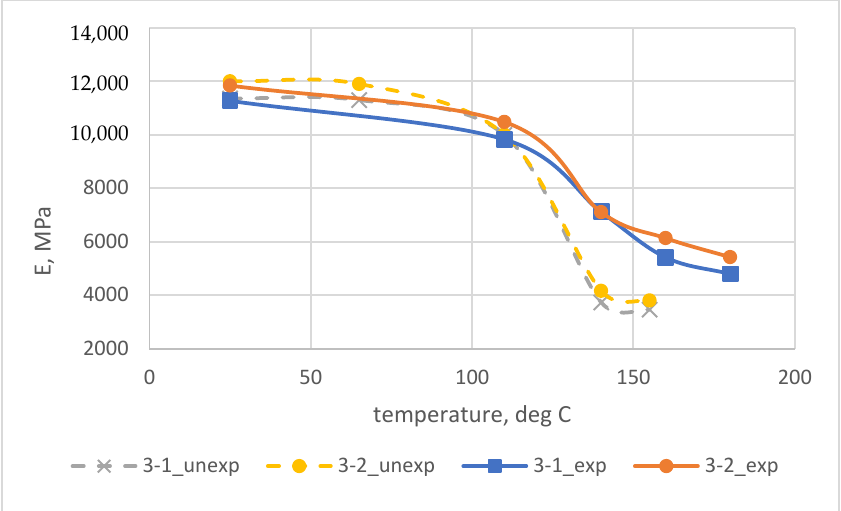
Figure 4. Experimental temperature dependence of elastic modulus (E) at bending of samples No. 3-1, 3-2 of epoxy fiberglass plastic based on T-23 glass fabric before (unexp) and after (exp) their exposure to temperatures exceeding the initial glass transition temperature.